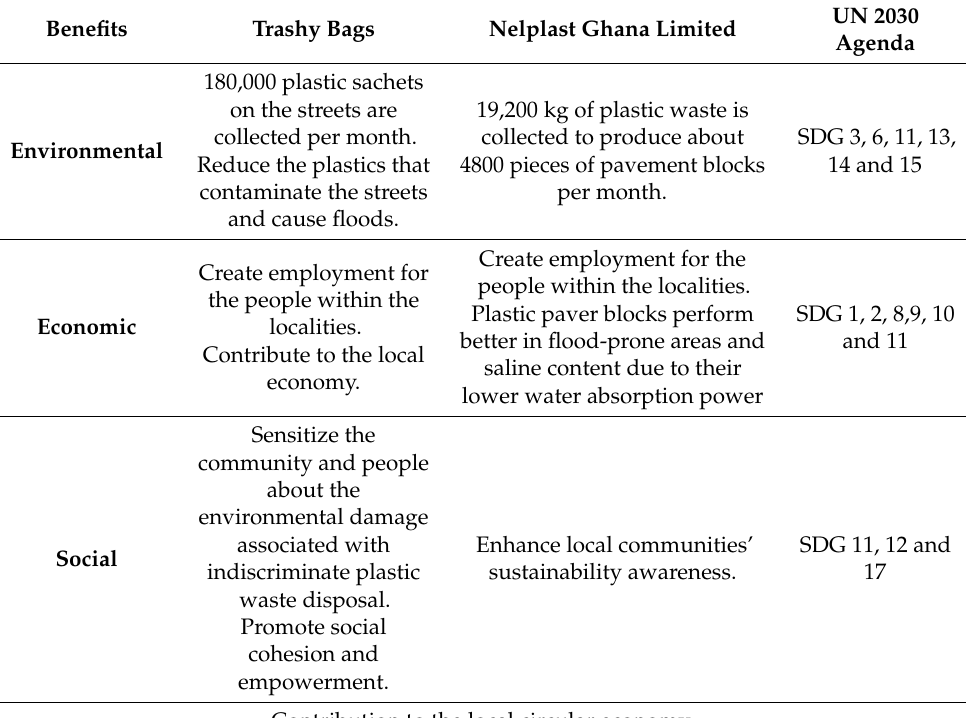
Table 1. Environmental, economic, and social benefits of the two LC presented and correspondent contributions to the UN 2030